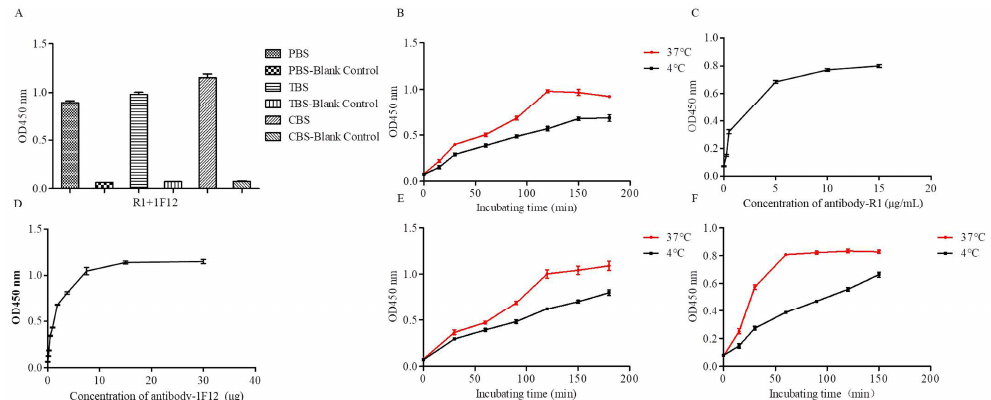
Figure 4. Optimization operations of DAS-ELISA. Optimum coating solution ( A ), coating temperatures and times ( B ) of pAb R1. Optimum working concentration of pAb R1 ( C ) and HRP-labeled mAb 1F12 ( D ). ( E ) Optimum incubating temperatures and times of antigen. ( F ) Optimum incubating times and temperatures of mAb 1F12-HRP probe.